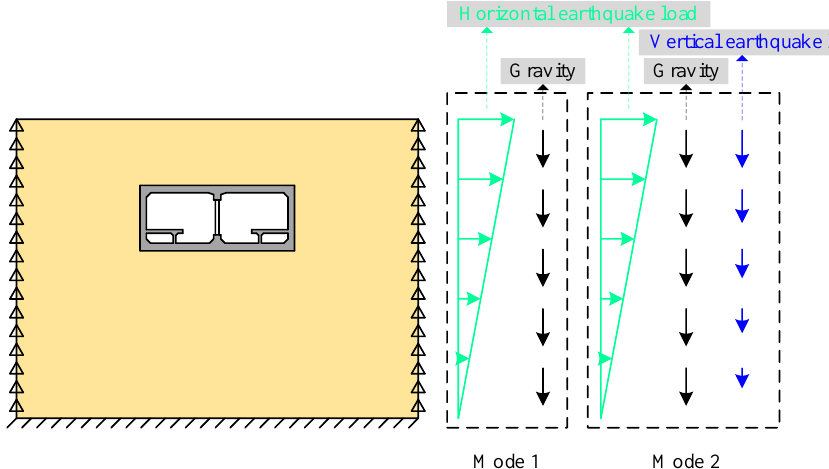
Figure 8. Pushover modes of soil-structure system.